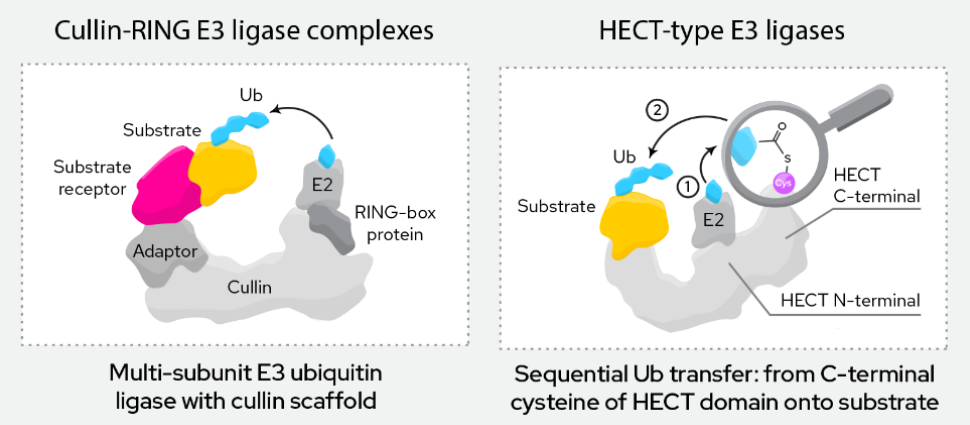
Figure 3. Most relevant classes of E3 ligases in TPD.